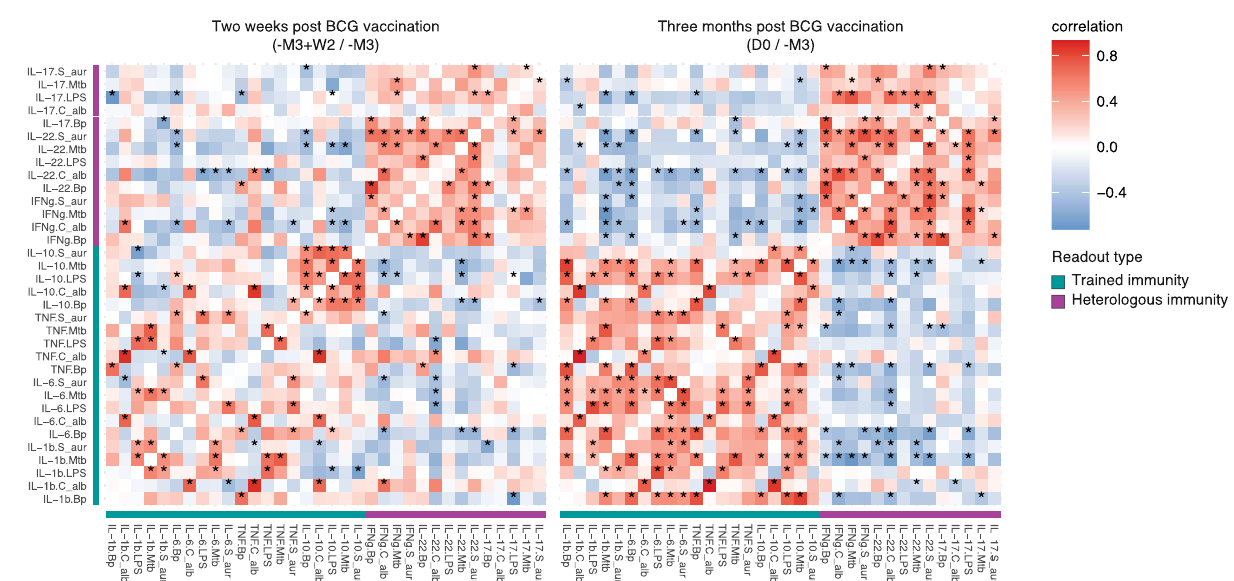
Fig. 4 BCG vaccination induces coordinated cytokine production in response to ex vivo stimulation. Within the BCG-trained cohort, log10 fold changes were calculated at 2 weeks (-M3 + W2/-M3) and 3 months post BCG (D0/-M3) for the indicated cytokine:stimulation combinations. Pearson correlations and associated signi fi cance between these changes are shown. Cytokines are labeled as readouts for heterologous immunity (purple) or trained immunity (turquoise). Data are N = 23 (left) and N = 22 (right), * p < 0.05. LPS lipopolysaccharide, Bp Bordetella pertussis , C_alb Candida albicans , Mtb Mycobacterium tuberculosis , S_aur Staphylococcus aureus